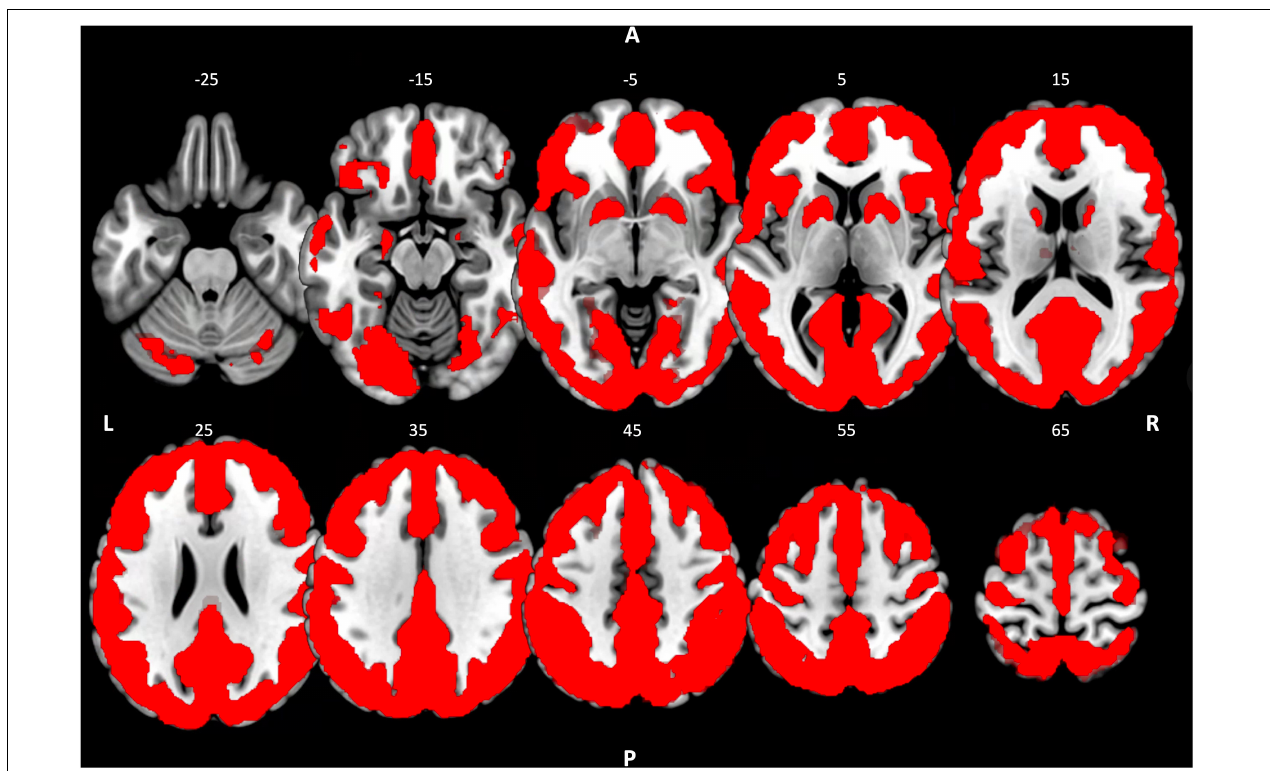
FIGURE 2 | Resting-state activity map. Binarized resting state activity map resulting from a one-sample t -test across groups with the concatenated fALFF-maps of R1, R2, and R3 of the control condition. Cluster-level threshold pFDR < 0.05. R, right; L, left; A, anterior; P,